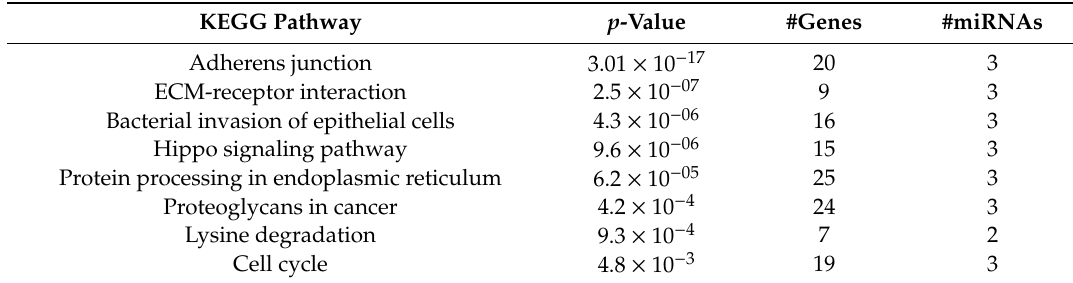
Table 3. Physiologic targets of candidate